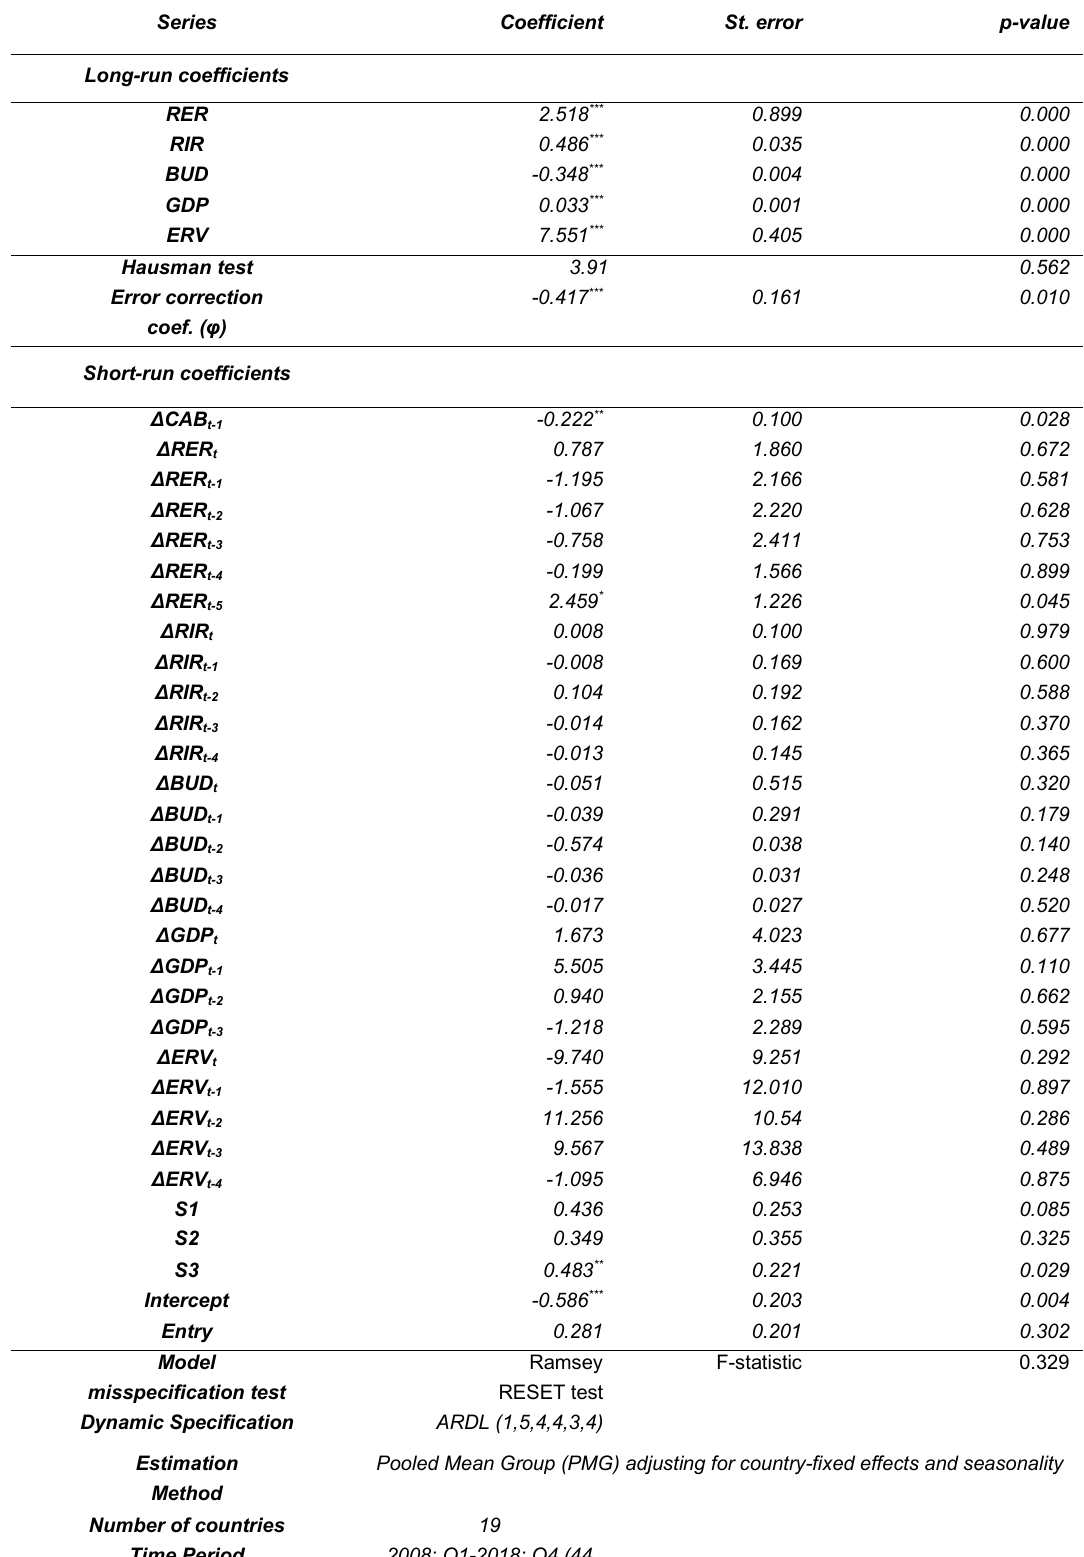
Table 4. Long-run and short-run coefficients of the current account balance